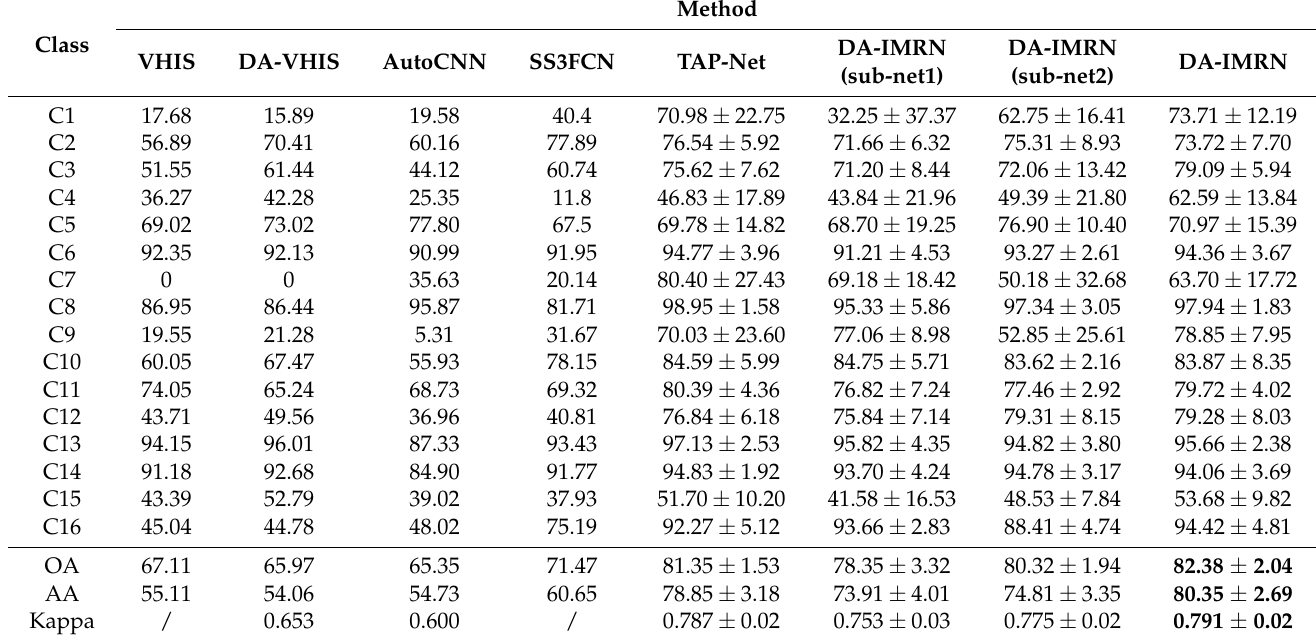
Table 5. Indian Pines dataset: Classification results in terms of the per-class accuracy, OA, AA (in %), and the Kappa scores. In the last four columns, the results are displayed in the form of mean ± standard